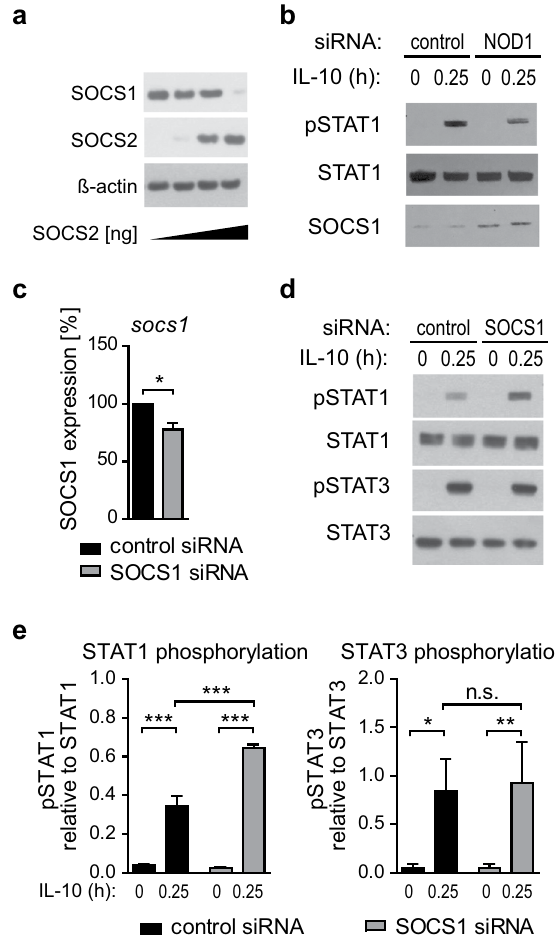
Figure 7. SOCS2 regulates SOCS1, and SOCS1 depletion specifically promotes STAT1 but not STAT3 activation. (a ) Effect of overexpression of SOCS2 on SOCS1 levels. HEK293 cells were transfected with constant amounts of SOCS1 plasmid and increasing amounts of SOCS2 plasmid. 48 hours post transfection, protein levels of SOCS1 and SOCS2 were measured by Western Blot. One representative experiment out of three is shown. ( b ) NOD1 and control silencing of iDCs was performed for 72 hours. Thereafter, cells were induced with IL-10 (30 ng/ml) for 15 minutes and pSTAT1, STAT1 and SOCS1 levels were analysed by Western Blot. One of two experiments is shown. ( c,d,e ) Immature DCs were transfected with siRNA directed against SOCS1 or a control siRNA. c Efficiency of SOCS1 silencing in iDCs was analysed by q-RT-PCR. ( d ) 72 hours post transfection, cells were induced with IL-10 (30 ng/ml) for 15 minutes and STAT1/3 phosphorylation was monitored using Western Blot analysis. To control for equal loading, total STAT protein was detected. One out of three independent experiments is shown. ( e ) Values of three independent experiments were used for quantification. Data represent mean and SD. For statistical analysis a one-way ANOVA with Tukey’s post hoc test was